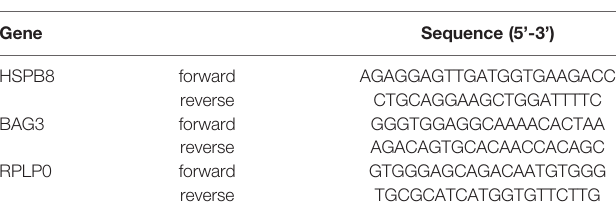
TABLE 2 | Primer List.